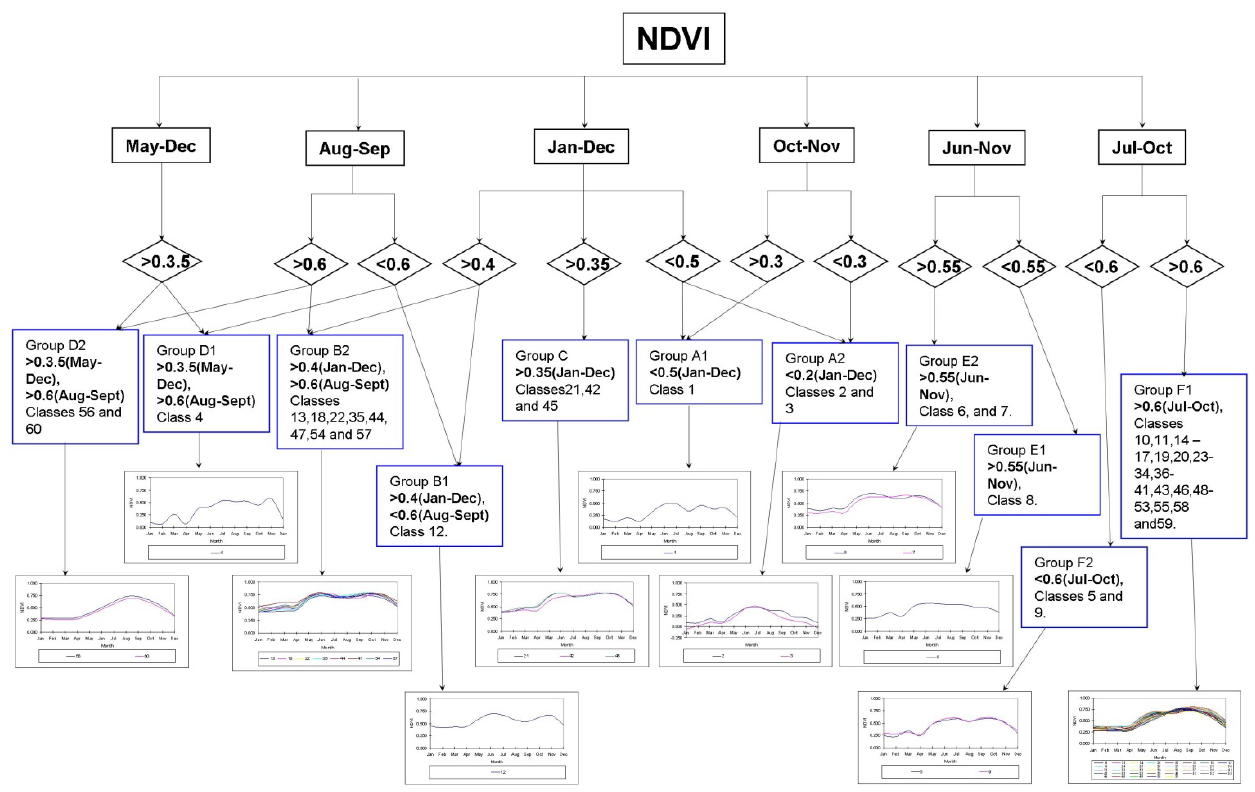
Figure 3. Decision tree algorithm for resolving 60 classes derived from Landsat ETM+ MODIS 250-m data. The Landsat 30-m data were classified along with NDVI